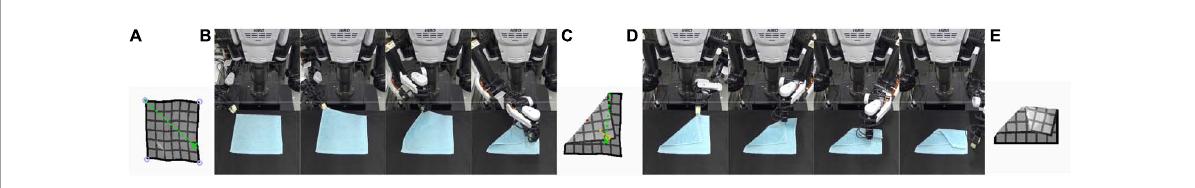
FIGURE1 Execution of a two-step manipulation plan. (A) Estimate of initial state and first planned manipulation (dotted green line). (B) Execution of first manipulation. (C) Planned intermediate goal and second planned manipulation (dotted green line). (D) Execution of second manipulation. (E) Goal